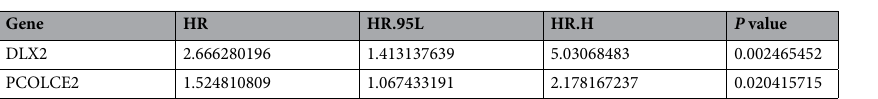
Table 1. Univariate Cox proportional hazard regression analysis of different genes.